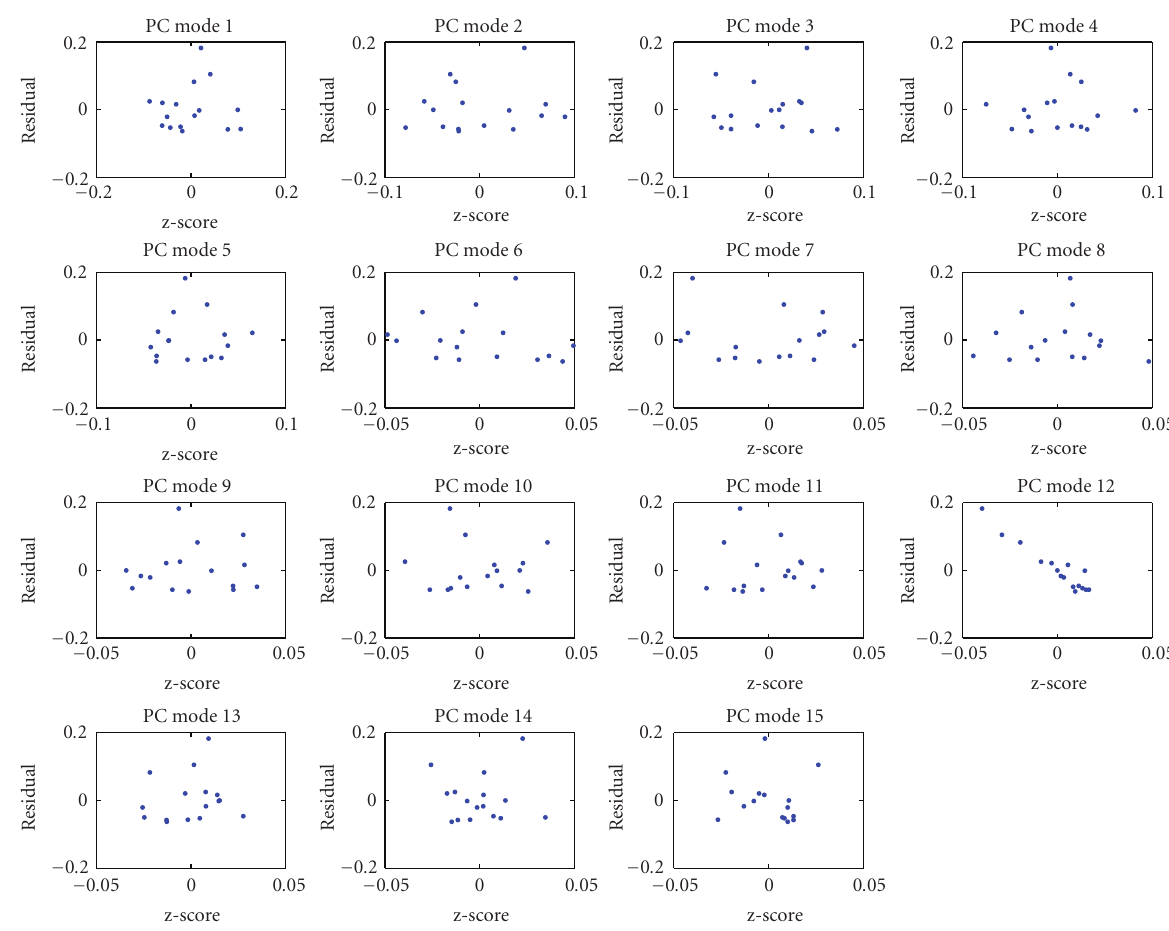
Figure 10: Correlation of PC mode parameters and modal force residual (Mode